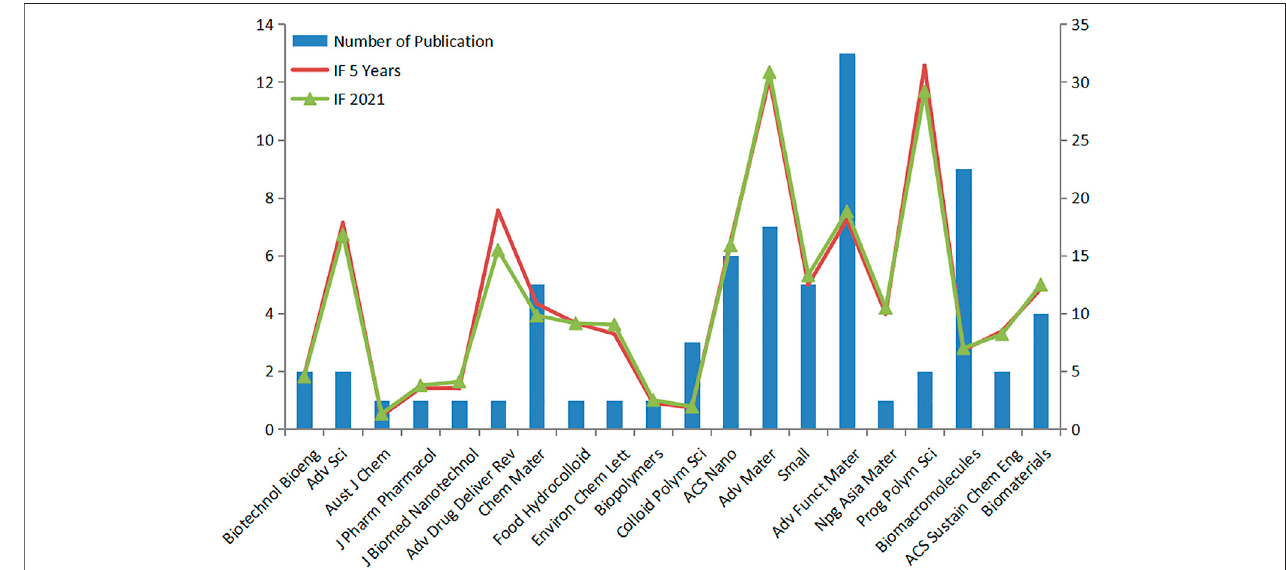
FIGURE 4 | Top 20 journals ranked by the average citation rate.